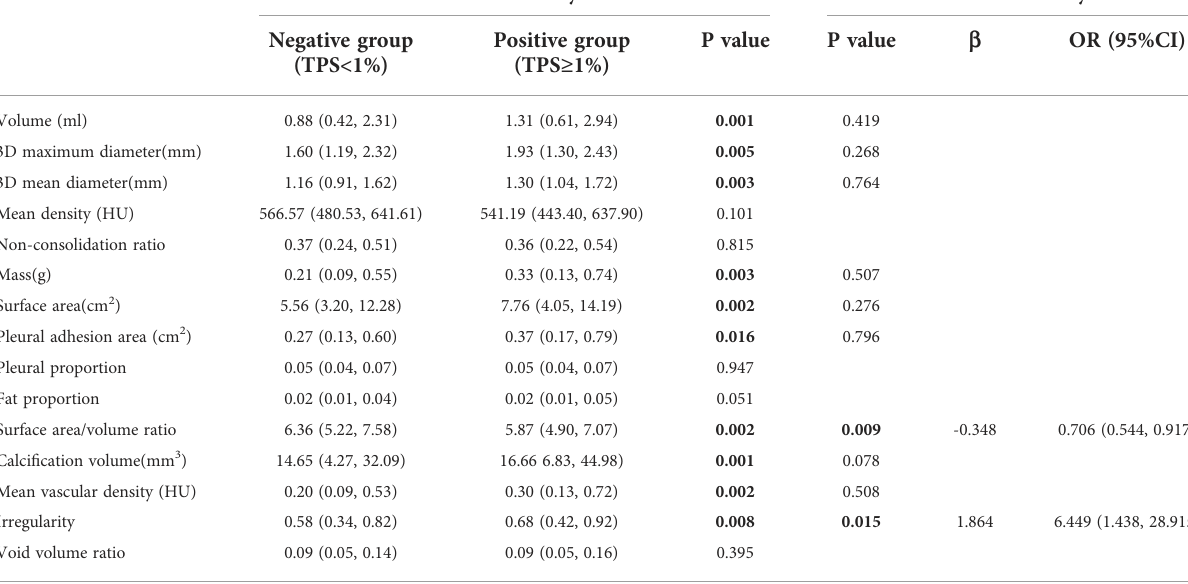
TABLE 4 Data analysis of quantitative features in training